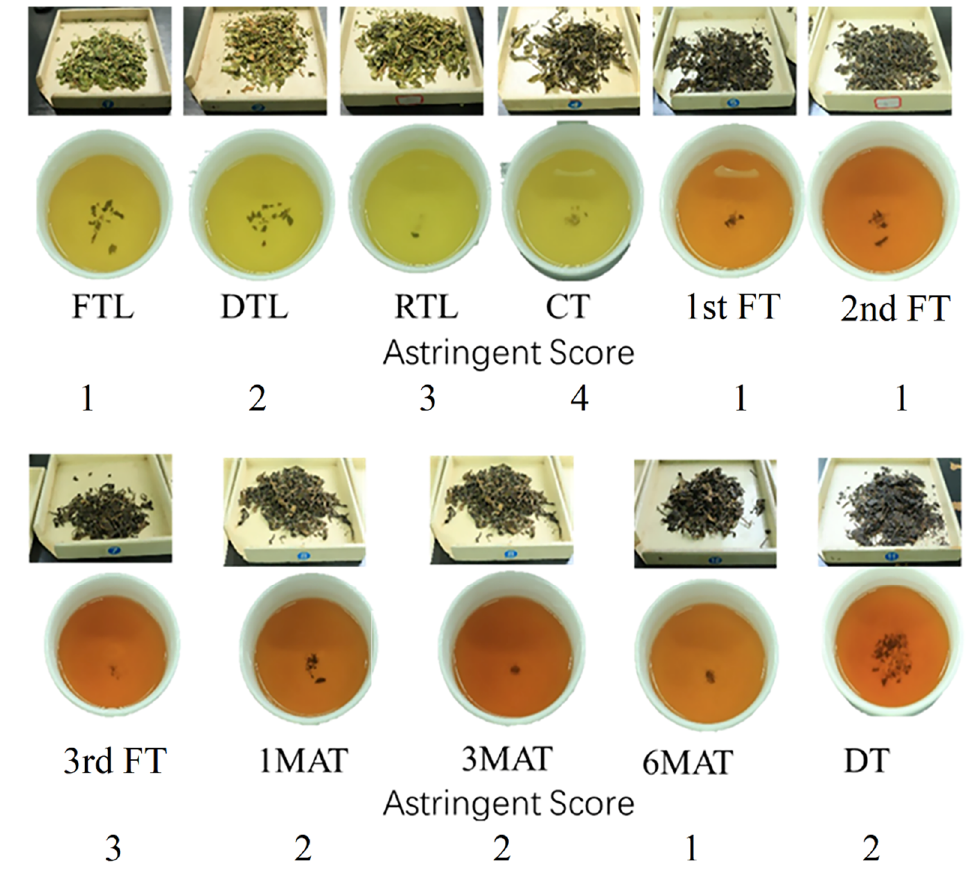
Figure 1. Sensory evaluation on the color and taste (mainly astringency) of QZT samples from the different processing stages. The first line above the abbreviations of tea samples showed the color of tea leaves, and the second line showed the color of tea infusions. The numbers under the abbreviations of tea samples represent their corresponding astringent scores.